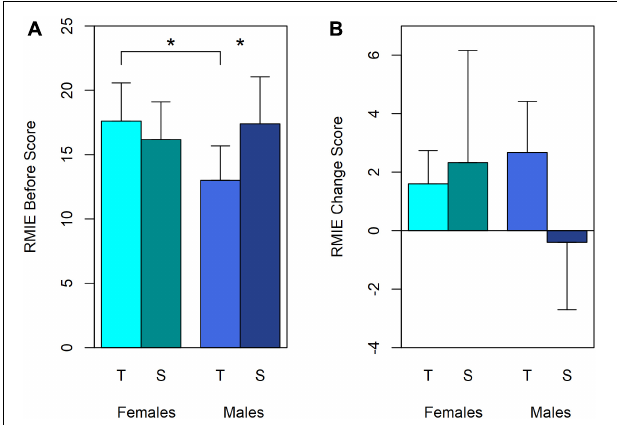
FIGURE 4 | Mean scores and standard deviations for the interaction between Treatment groups and Sex in RMIE Before (A) and Change scores (B) . Cyan bars: mean scores for Females. Blue bars: mean scores for Males. T, Turn-taking; S, Synchrony. Error bars are the standard deviation. Positive Change scores represent improved performance (After > Before). * p < 0.03 in